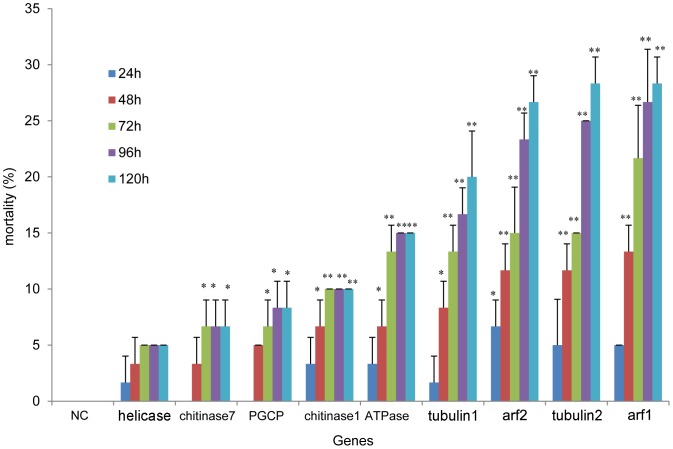
The mortality in RNAi-treated groups at different times after injection.The mortalities were calculated at 24, 48, 72, 96 and 120 h after injecting siRNAs. The group injected with siRNA with a random sequence was used as the negative control (NC). We did not observe mortality in the NC group. No mortality was observed at 24 h post injection in the chitinase 7 and PGCP siRNA group. Knockdown of eight genes led to significantly high mortality at 72, 96 and 120 h after siRNA injection. All data were analyzed with student T-test (* P<0.05, **P<0.01).